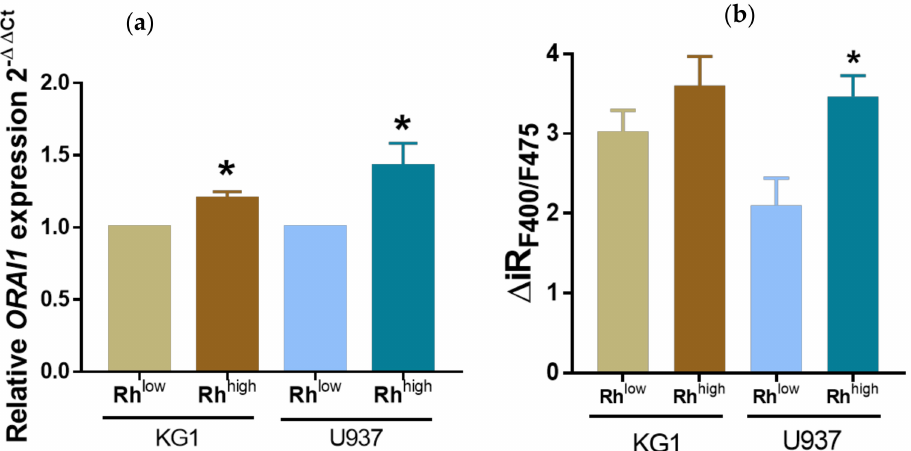
Figure 5. SOCE is downregulated in the KG1 and U937 Rh123 low cell subpopulations. ( a ) Relative ORAI1 expression in KG1 and U937 Rh123 low and Rh123 high cell subpopulations determined by RT–qPCR. ORAI1 relative expression was calculated by the 2 − ∆∆ Ct method. * p < 0.05. ( b ) [Ca 2+ ] i was monitored by flow cytometry, and the F400/F475 ratio reflected calcium capacitive entry in KG1 and U937 Rh123 low and Rh123 high cell subpopulations. The graphs represent the means of 3 independent experiments. * p ≤